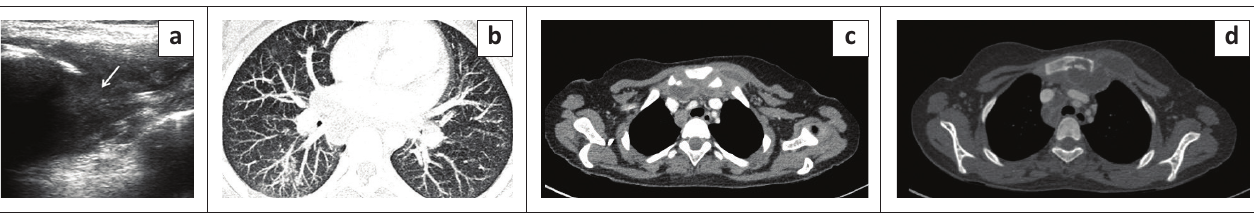
FIGURE 4: A 15-year-old female with a subtle swelling on the chest wall. Ultrasonography image (a) shows a hypo-echoic collection (arrow) in the upper anterior chest wall in relation to the left sternoclavicular joint. Axial lung window computed tomography image (b) shows tree in bud nodular opacities in the right lower lobe superior segment. Axial soft tissue (c) and bone (d) window computed tomography images show necrotic mediastinal nodes and involvement of both sternoclavicular joints with hypodense collections and adjacent bony